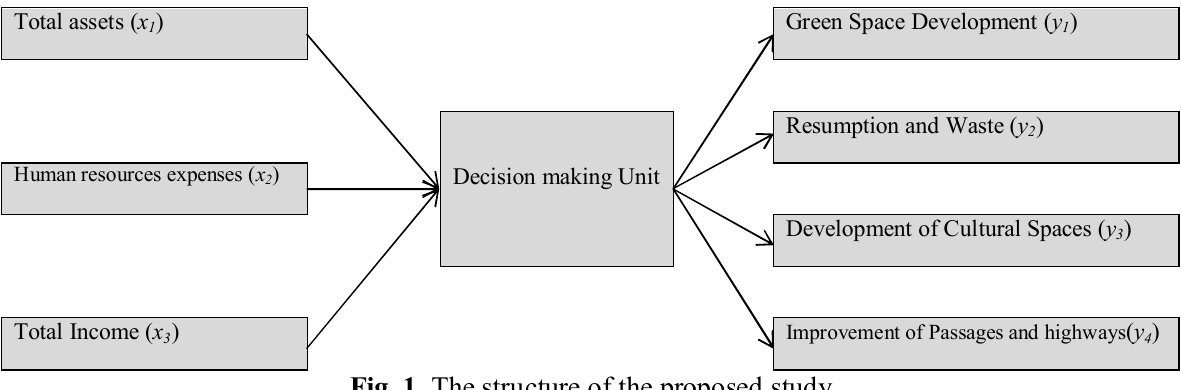
Fig. 1. The structure of the proposed study